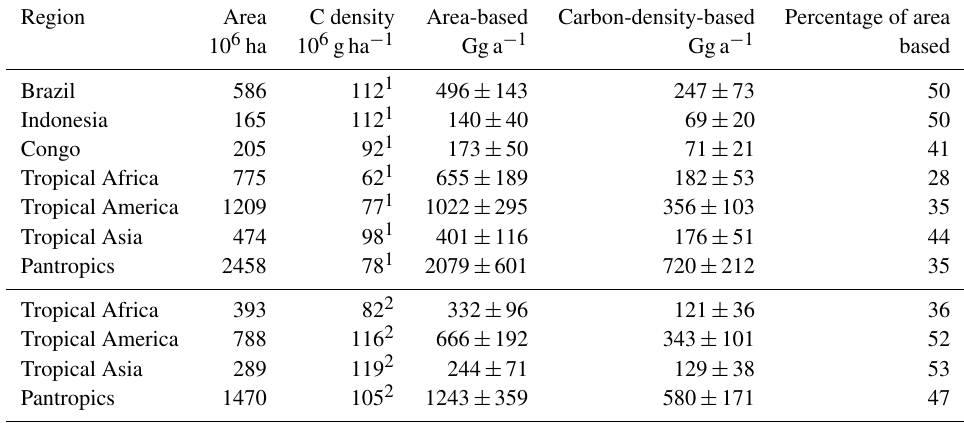
Table 6. Comparison of calculated area-based and carbon-density-based emissions from tropical